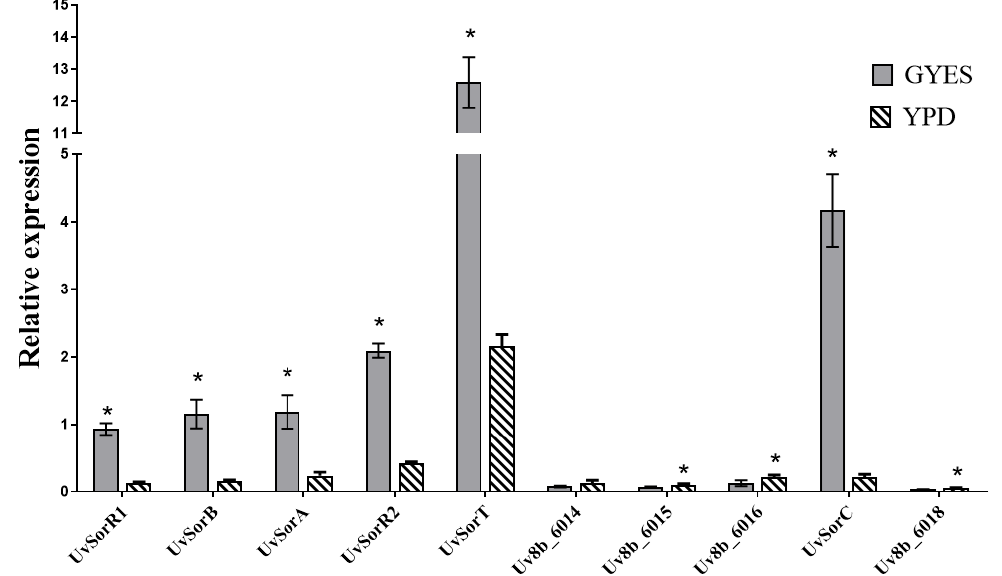
Figure 1. Identification of the sor BGC in U. virens . ( A ) Comparison of sor BGCs among U. virens, P. chrysogenum, T. reesei, and A. chrysogenum. Orthogous genes were presented with the same colors; ( B ) HPLC profiles of the methanol extracts of the mycelia cultured on the sorbicillinoids-producing medium (GYES) and sorbicillinoids-non-producing medium (YPD) detected at 370 nm (left panel). The peaks were identified as sorbicillinoids by LC − MS. Colony morphologies (front view) observed after 28 days of culture on the GYES and YPD plates (right panel); ( C ) The expression pattern of sor BGC genes analyzed by RNA − Seq. The fold change was equal to averaged FPKM of U. virens cultured in GYES/YPD; ( D ) The qRT − PCR expression level of sor BGC genes in U. virens cultured in GYES compared to YPD medium. The values represent the average ± SD of three biological replicates. The asterisk (*) represents a significant difference at p < 0.05.